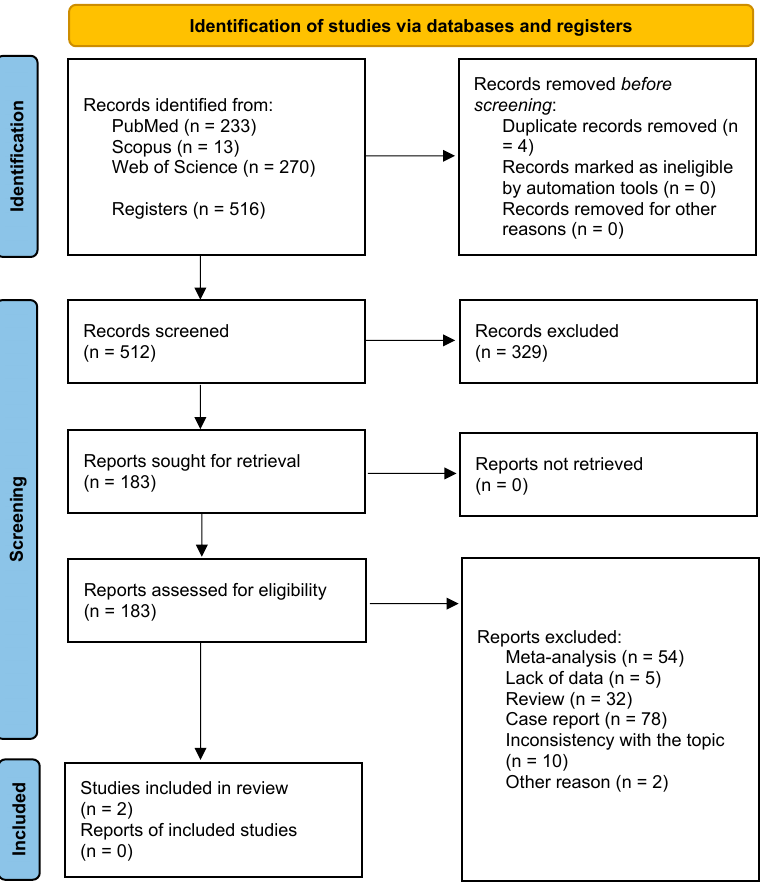
Figure 1. PRISMA flow diagram of the study inclusion